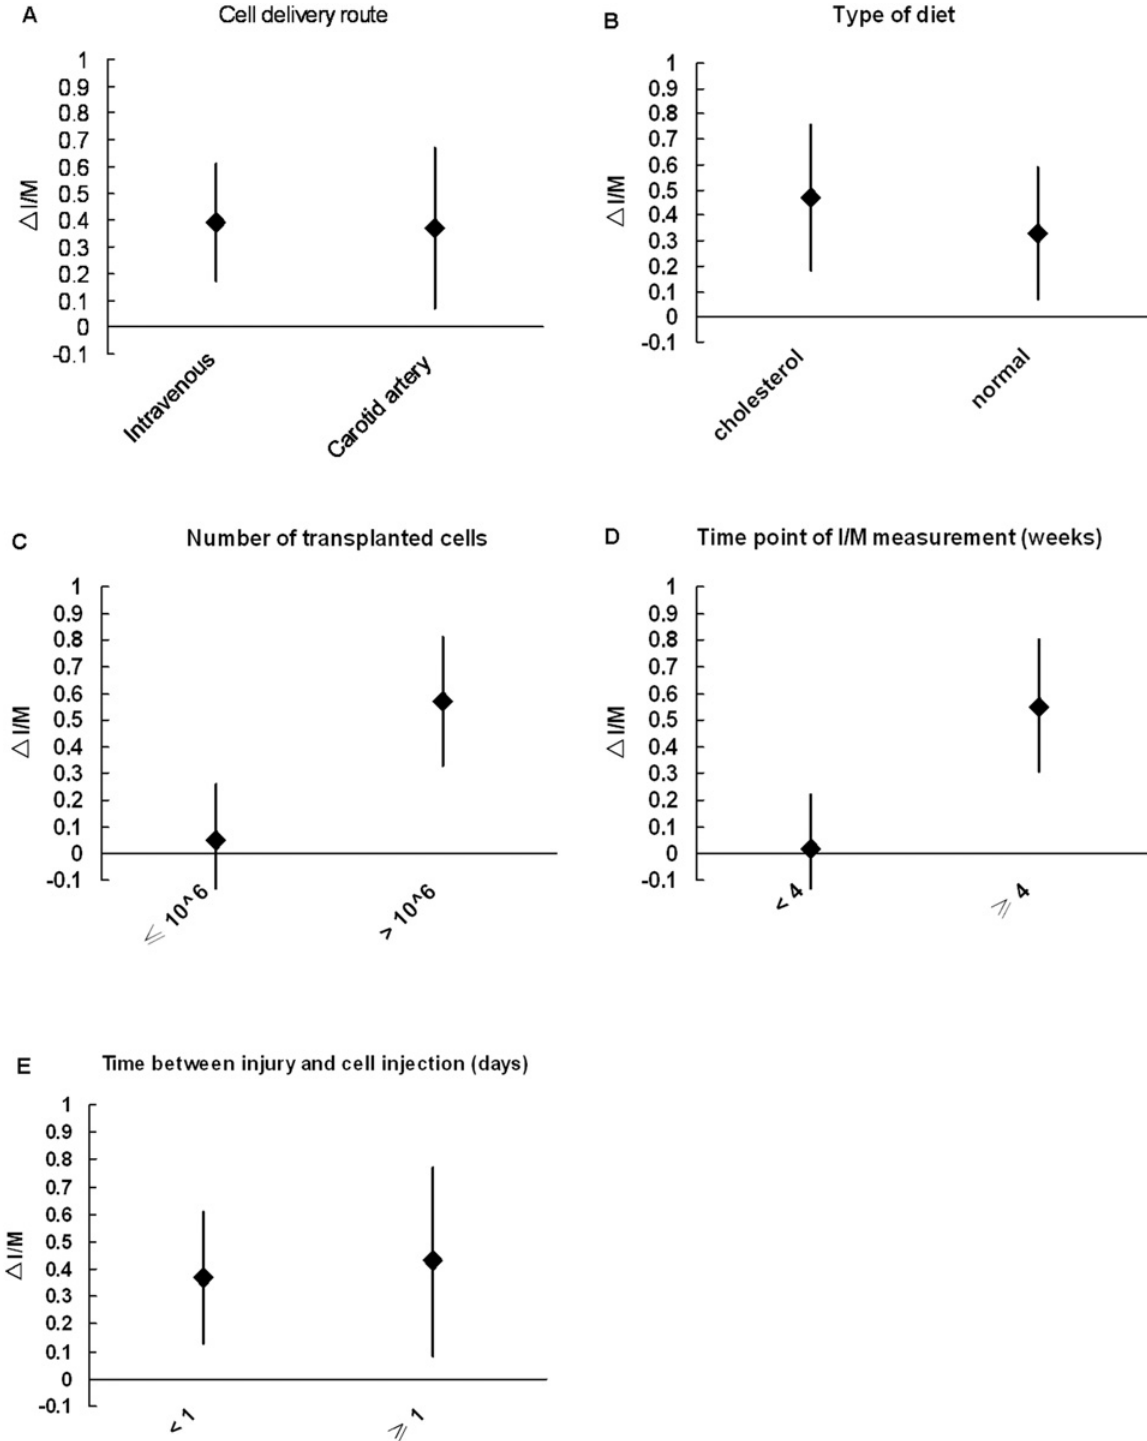
Fig 3. Sensitivity analysis showed a trend towards greater reduction in neointima/media (I/M) with mesenchymal stem cell (MSC) engraftment, compared with controls, with (A) intravenous cell transplantation route (P = 0.139); (B) cholesterol diet (P = 0.629); (C) high cell numbers ( > 10 6 ; P = 0.017); (D) I/M measurement later after MSC engraftment ( (cid:3) 4 weeks; P = 0.022); and (E) later cell engraftment ( (cid:3) 1 day; P = 0.437).